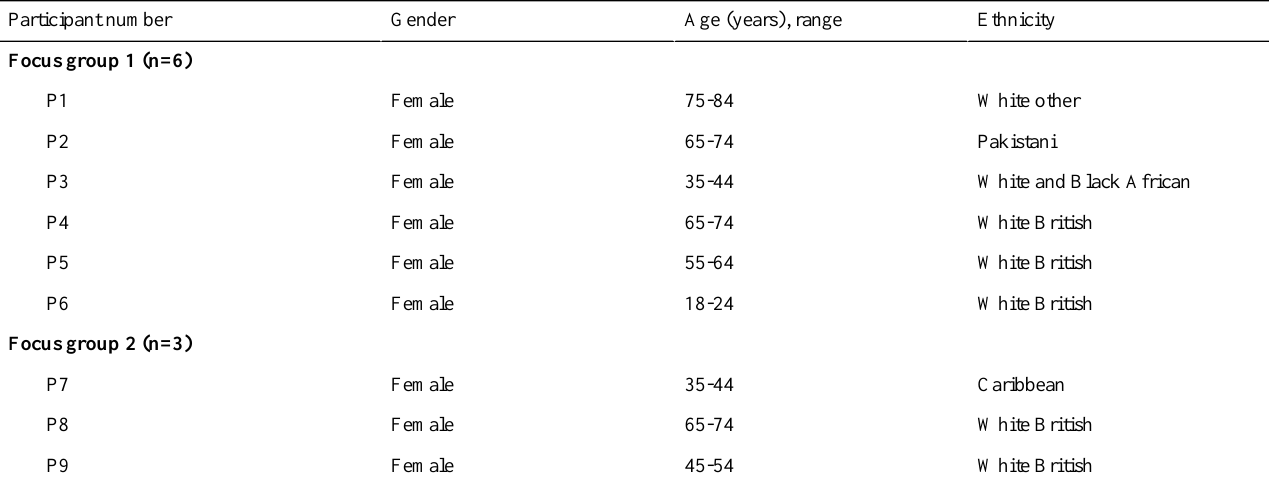
Table 1. Participant